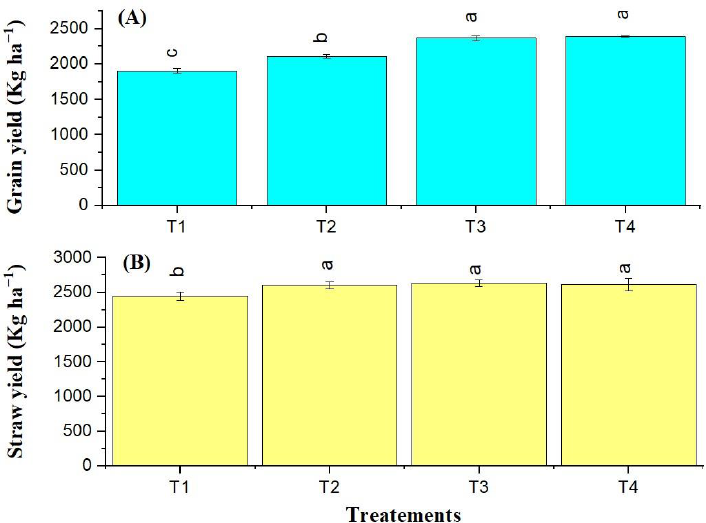
Figure 5. Effect of gypsum treatments on the ( A ) grain yield and ( B ) straw yield. Different lowercase letters indicated the significant difference between treatments at p < 0.05.